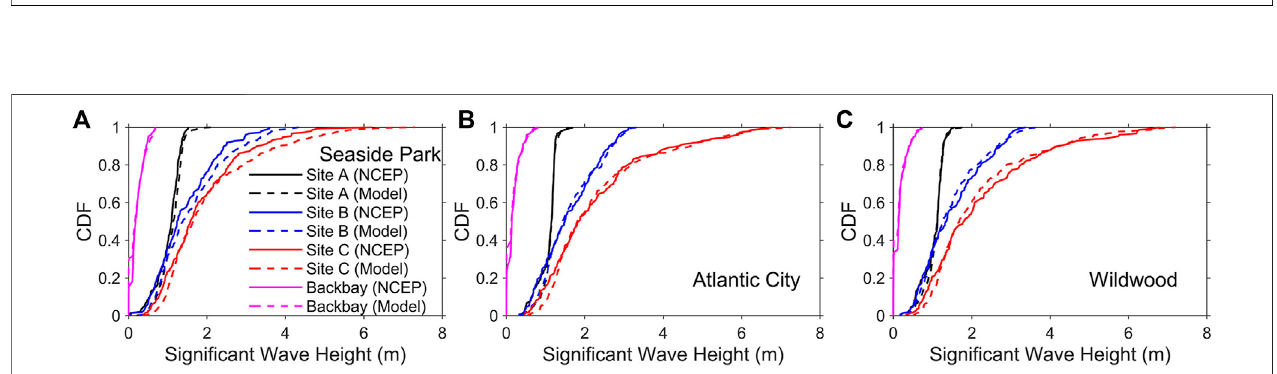
FIGURE 4 | Historical mean and 95th-percentile SWH for the NCEP- and climate model-based major hurricane datasets. Each data point represents mean (or 95th-percentile) SWH at a speci fi c computational node. Only nodes at a water depth of 20 m or shallower are considered. The scales of axes are different. The density refers to the number of data points in 0.05 m by 0.05 m cells in each plot.